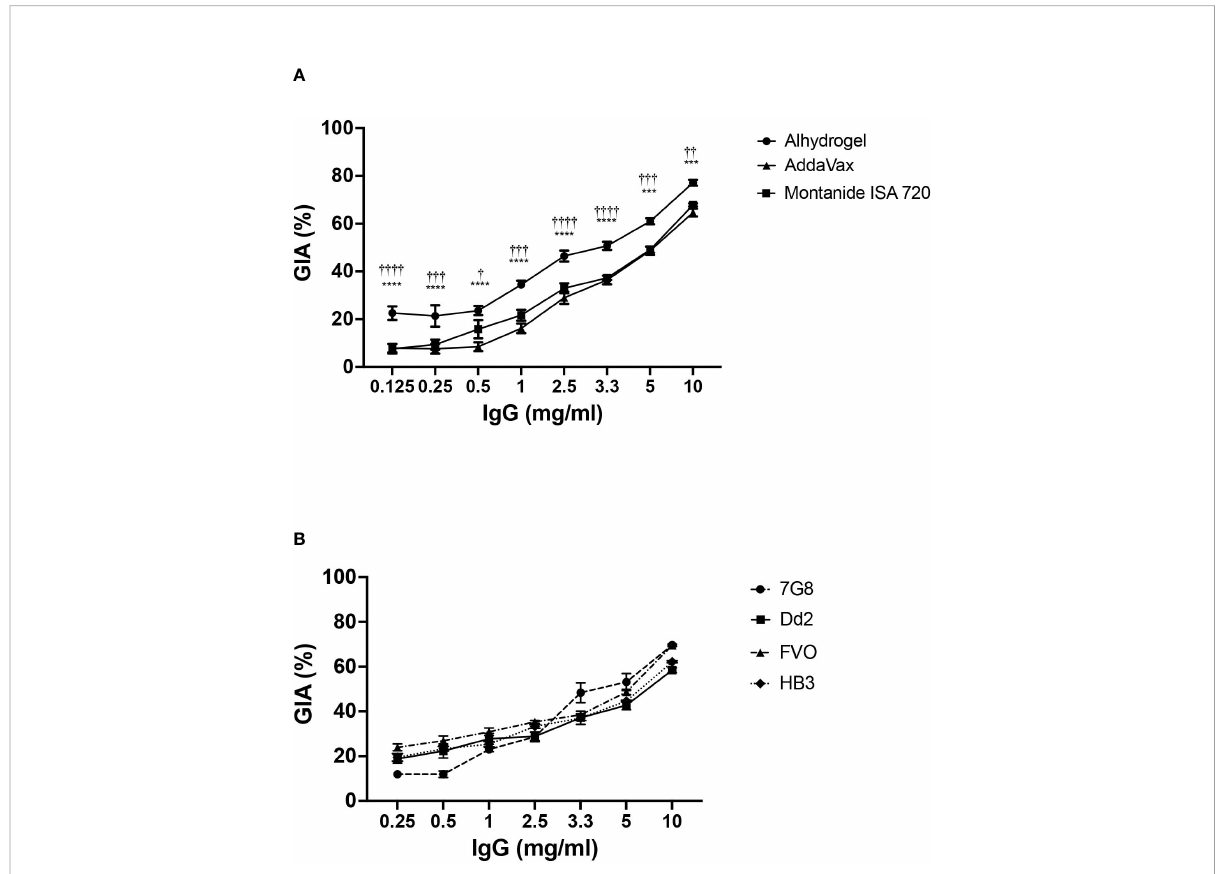
FIGURE 7 Parasite Neutralizing Ef fi cacy of Antibodies against CyRPA Vaccine Formulated with Commonly used Adjuvants (A) Puri fi ed rabbit total IgG against the different tag-free CyRPA vaccine formulations (Alhydrogel, AddaVax and Montanide ISA 720) were tested in the standard in vitro Growth Inhibitory Assay (GIA) against 3D7 clone in a one-cycle assay. All the formulations elicited parasite neutralizing antibodies, however, anti-CyRPA/Alhydrogel IgG antibodies were the most ef fi cacious exhibiting signi fi cantly higher inhibition levels that reached to ~80% at 10 mg/ ml. Data represents the average of 2 independent experiments conducted in duplicate. The error bars represent the standard error between the 2 independent GIA experiments. The P values were calculated by two-way ANOVA with Bonferroni post-hoc testing. *indicates P value difference between Alhydrogel and AddaVax groups. † indicates P value difference between Alhydrogel and Montanide ISA 720 groups. (B) Total IgG against tag-free CyRPA/Alhydrogel was tested against four P. falciparum clones, 7G8, Dd2, FVO and HB3, in a one-cycle GIA. The antibodies exhibited a strain-transcending parasite neutralization across the four strains achieving the inhibition level of ~70% (7G8 and HB3) and ~60% (Dd2 and FVO). Data represents the average of 2 independent experiments conducted in duplicate. The error bars represent the standard error between the 2 independent GIA experiments. The P values were calculated by two-way ANOVA with Bonferroni post-hoc testing. *** P ≤